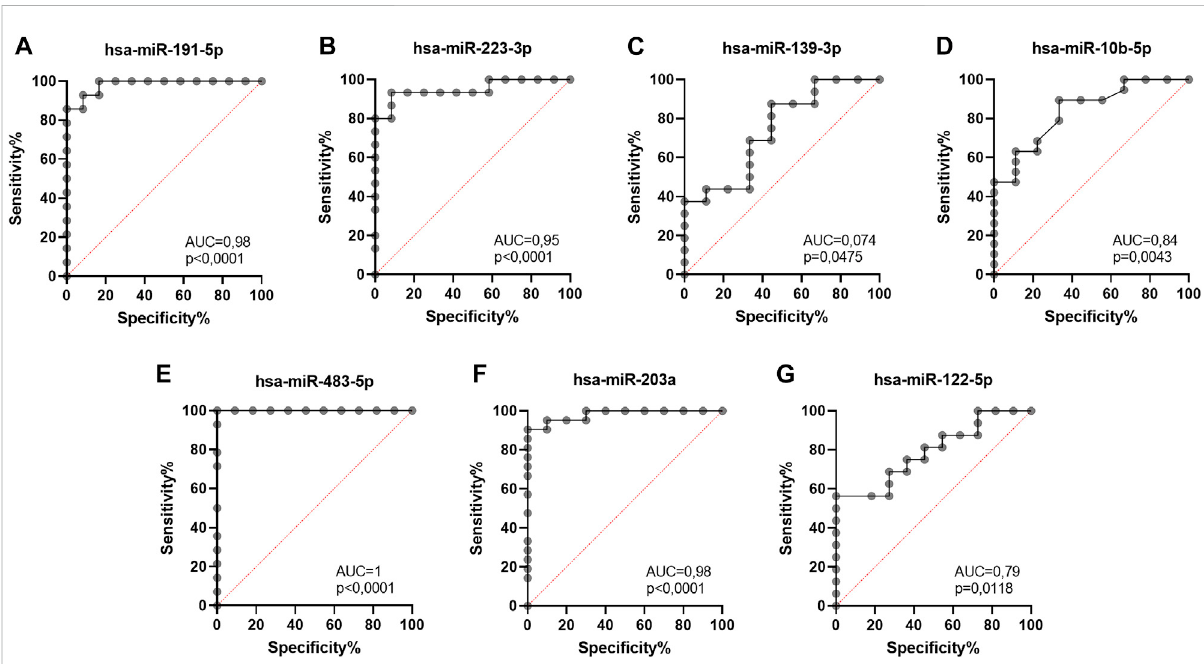
FIGURE 5 Receiver operating characteristic (ROC) curve analysis of differentially expressed hsa-miR-191-5p (A) , hsa-miR-223-3p (B) , hsa-miR-139-3p (C) ,hsa-miR-10b-5p (D) ,hsa-miR-483-5p (E) ,hsa-miR-203a (F) ,hsa-miR-122-5p (G) inEVsderivedfromheathydonorsandUMpatientsregardless of the disease stage, based on RT-qPCR data. AUC — area under curve; p = p